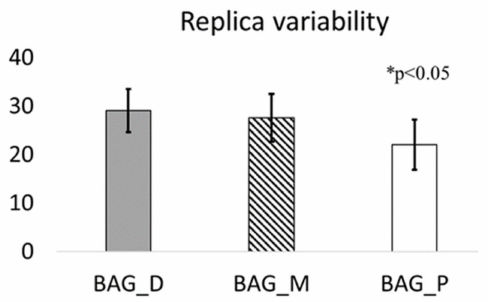
Figure 5. Total element load for each bag position (proximal: P; middle: M; distal: D). Replicas were scored based on their element content between 1 and 3, where 3 represents the highest content and 1 the lowest. The scores of each element were summed to obtain total element load ( y axis) and the mean values were compared by ANOVA. * p < 0.05 according to Tuckey’s post-hoc